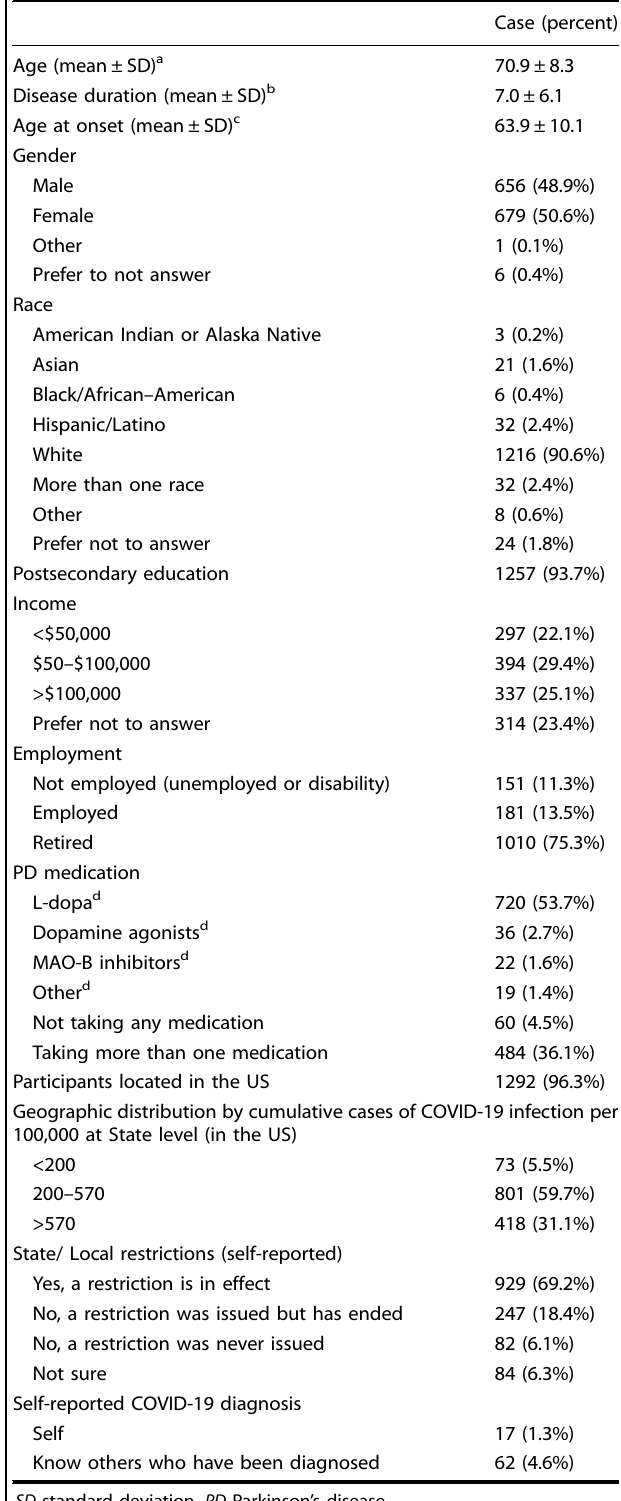
Table 1. People with Parkinson ’ s disease respondent